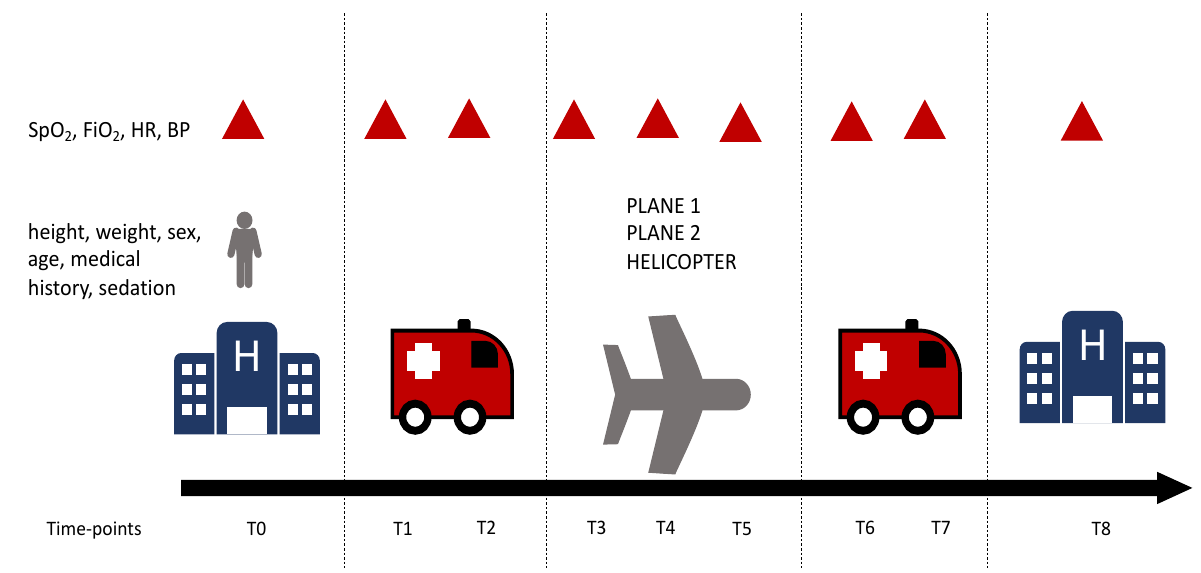
Figure 1. Patient’s journey. SpO 2 = pulse oxygen saturation, FiO 2 = inspired fraction of oxygen; HR = heart rate; BP = invasive blood pressure; T0 = before leaving the starting ICU, T1 = at the beginning of the transport between the starting ICU and the airport or drop zone (DZ), T2 = at the end of the transportation between the starting ICU and the airport or DZ, T3 = at the beginning of the flight, T4 = in the middle of the flight, T5 = at the end of the flight, T6 = at the beginning of the transport between the airport or DZ and the arrival ICU, T7 = at the end of the transportation between the airport or DZ and the arrival ICU and T8 = arrival in the ICU.